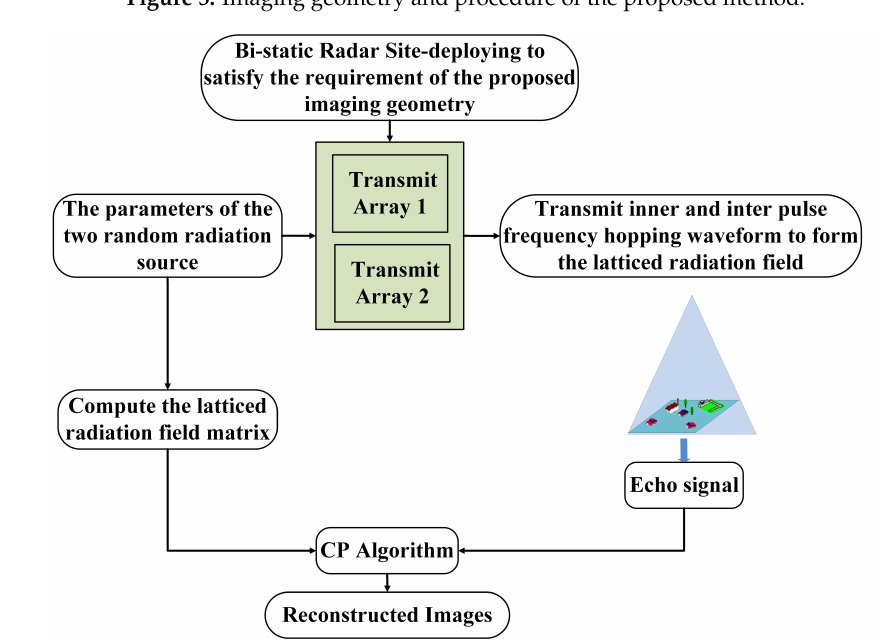
Figure 6. Flow chart of the proposed bi-static MSCI